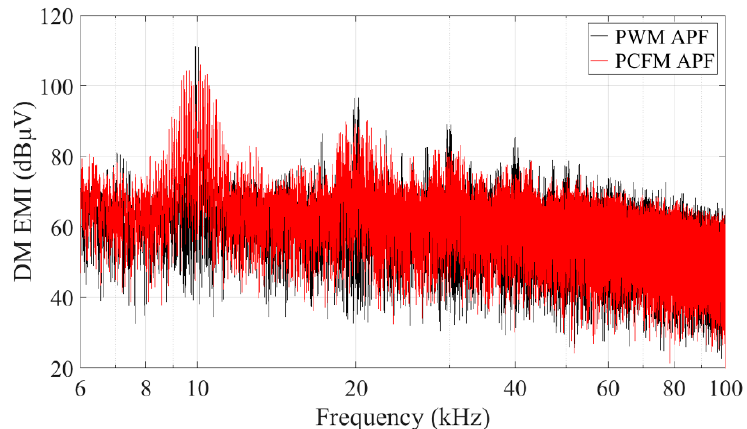
Figure 18. Experimental results of the DM EMI v DMEMI of APF under the nonlinear load II (Sawtooth PCFM APF with ∆ f c = 800 Hz).